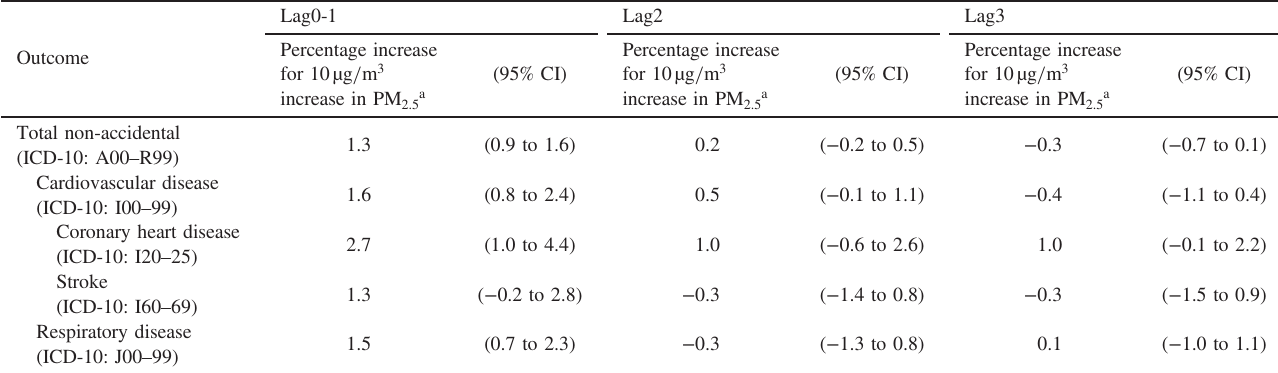
Table 3. Pooled estimates for the association between PM 2.5 exposure and mortality in 100 Japanese cities, April 2012 to March 2015